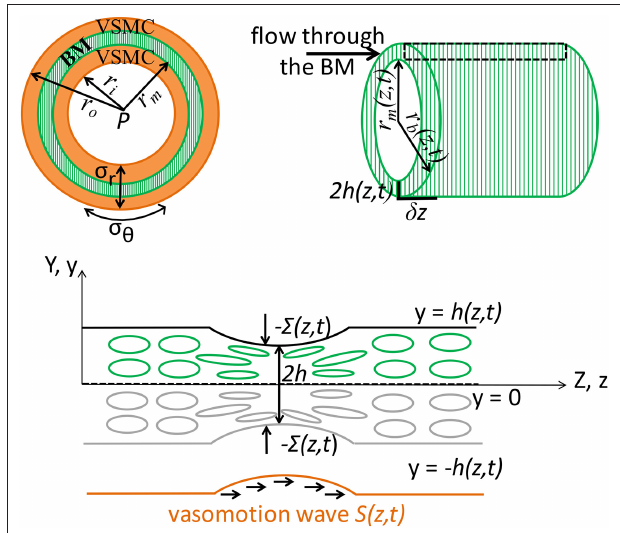
FIGURE 2 | Schematic representation (not to scale) of the V-IPAD model. A leptomeningeal artery is modeled as a long thick-walled cylinder with uniform material properties along its length, maintained at a constant intraluminal pressure P and constant longitudinal stretch and exposed to active contractions of VSMCs. The top layer shows the arterial cross section with a layer of BM (green compartment) embedded in the wall (Left) and the longitudinal section of the BM (Right) . For simplicity reasons, only one layer of BM is considered at the middle of the wall and the two layers of the VSMCs surrounding the BM are assumed to behave identically. The remaining wall components are not shown, but their effect on the wall elasticity is captured by the radial ( σ r ) and circumferential stress ( σ θ ). The deformed inner radius, middle radius and outer radius of the arterial wall are denoted by r i , r m , and r o , respectively. The position of the inner layer bounding the BM is assumed at r m and, owing to stress continuity across the wall, the radial stress σ r at that point represents the external compressive stress 6 which acts on the BM, i.e., 6 = σ r ( r = r m ); thereby, the arterial wall model is coupled with the BM model. Both r m and 6 depend on the prescribed vasomotion wave S ( z , t ) generated by the contractile VSMCs and are determined from the arterial wall model. The position of the outer layer bounding the BM is assumed at r b with r b = r m + 2 h , where 2 h denotes the whole BM thickness. Since the BM thickness is significantly smaller than the arterial radius, its upper half is assumed to behave identically to its lower half. The deformed thickness h = h ( z , t ) of the upper-half BM is determined by solving the BM model in the Cartesian system ( y , z ) and this is justified by the relationship r b = r m ( z , t ) + 2 y where 2 y ≪ r m and 2 h ≪ r m . The area delimited by the rectangular is illustrated in the bottom schematic: a sheet of BM modeled as a poroelastic compartment whose fluid-filled pores are squeezed during the VSMC contractions, under the direct actions of − 6 ( S ( z , t )), driving the fluid out of the BM pores in the direction of the vasomotion wave.